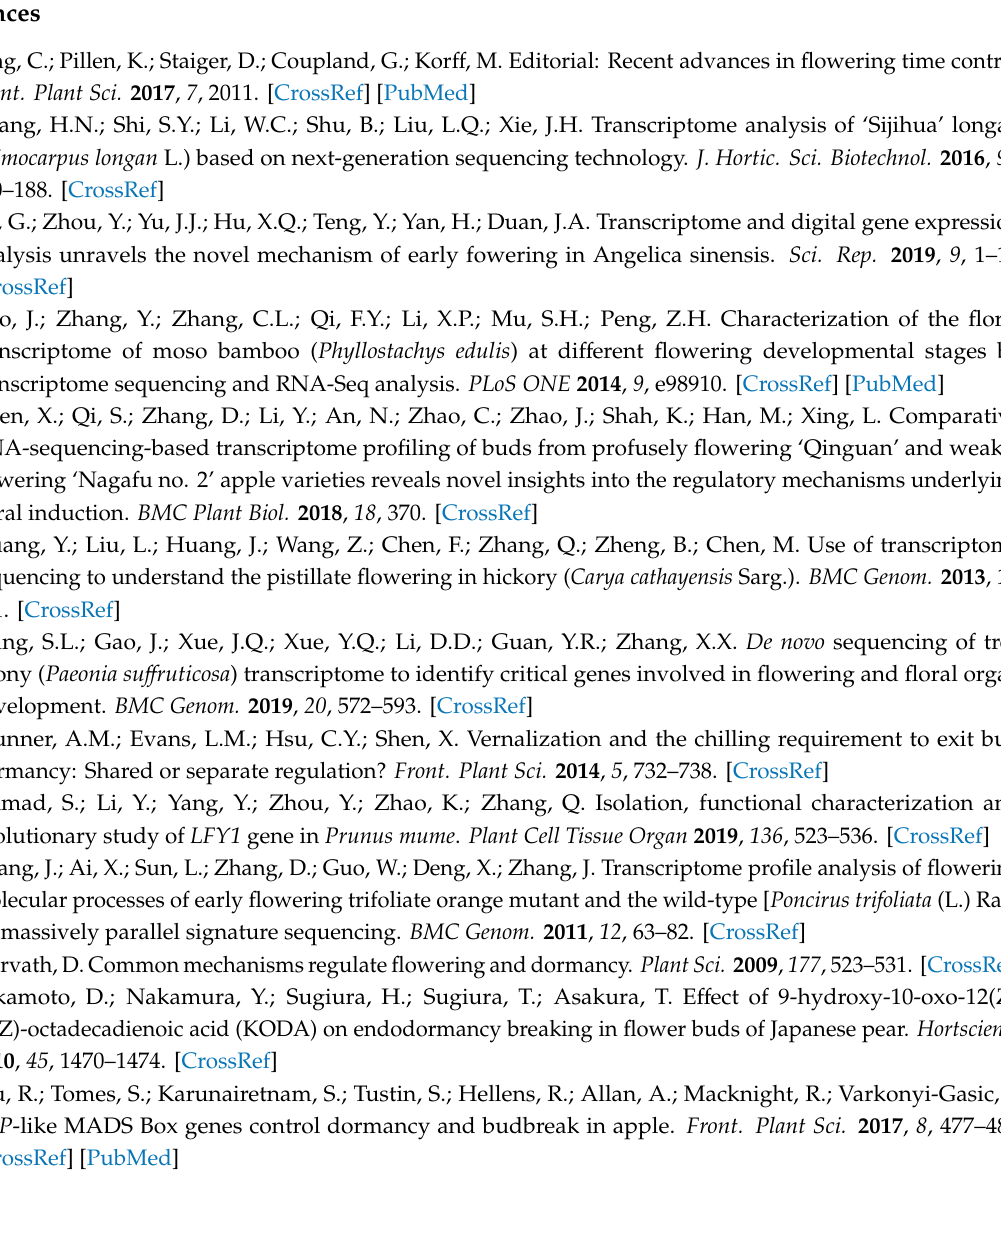
Table S8: Expression level and annotations of GAI . Table S9: Expression level and annotations of RGL1 -like. Table S10: Sequencing data quality statistics results; Table S11: Unigene quality statistics results. Table S12: Gene expression statistics in 12